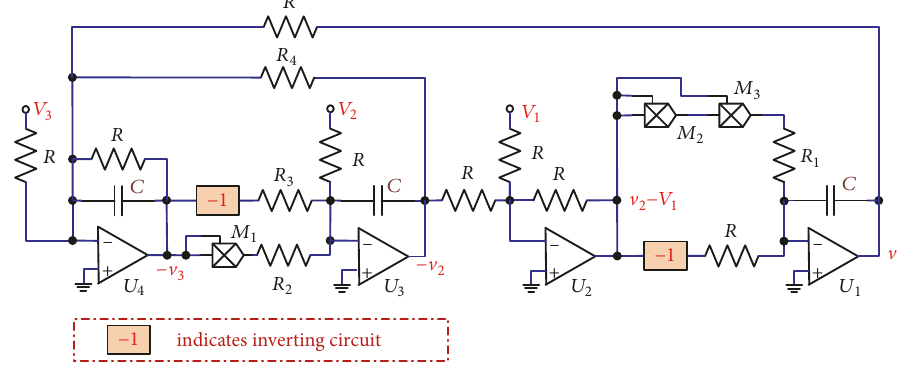
Figure 13: Schematic diagram of the implementation circuit for the third-order reconstructed memristive system.